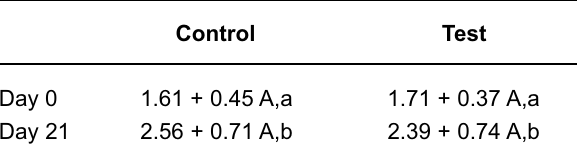
Means followed by the same uppercase letters on day 0 and day 21 do not differ statistically (p>0.05). Means followed by different lowercase letters in the same column differ statistically (p<0.01). TABLE 2- Bleeding Index (BI) means and standard deviation on day 0 and day 21 for the control and test groups